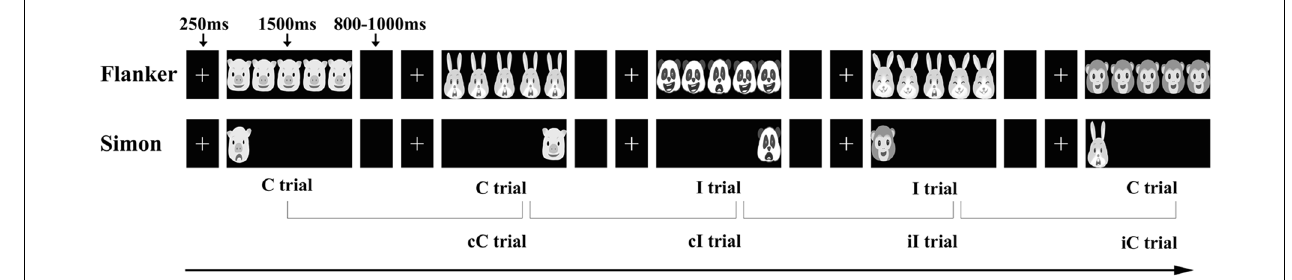
FIGURE 1 | Representative examples of the emotional Flanker task and emotional Simon task. Note: C, congruent trial; I, incongruent trial; cC, congruent trial preceded by a congruent trial; cI, incongruent trial preceded by a congruent trial; iC, congruent trial preceded by an incongruent trial; iI, incongruent trial preceded by an incongruent